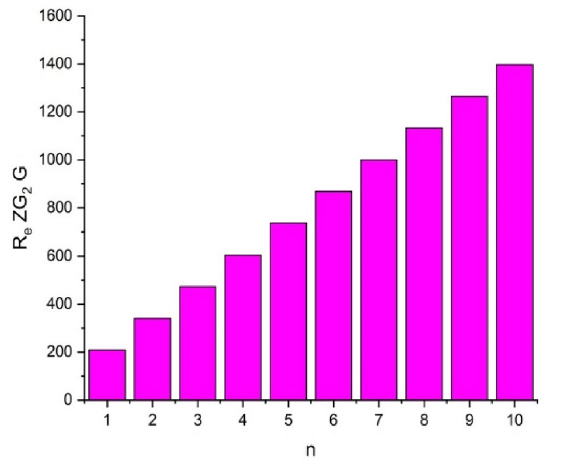
Figure 15. The comparison of n and . R e ZG 2 ( G )